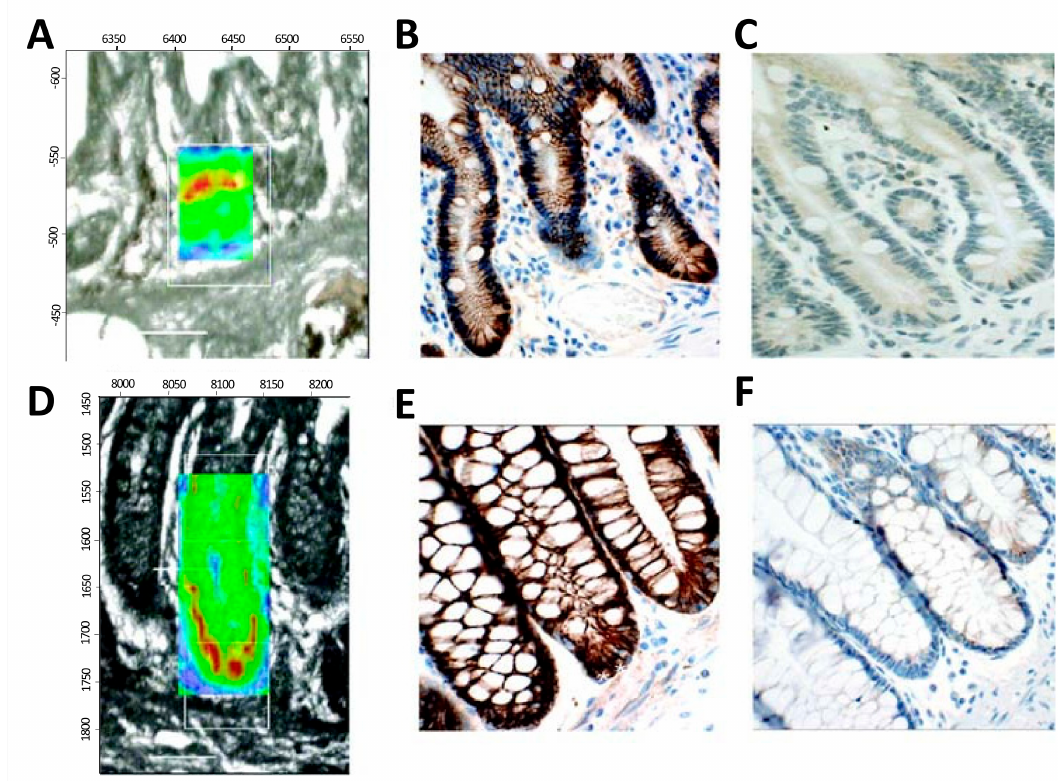
Figure 5. Localisation of the putative stem cell region in an IR spectral image (resolution of 8 µ m × 8 µ m) map of intestinal crypts obtained using synchrotron FTIR micro-spectroscopy; a comparison with proposed immunophenotypical markers. ( A ): Two-dimensional (2D) map of a small intestinal crypt, smoothed at the wavenumber 1080 cm − 1 and superimposed on the unstained region analysed. ( B ): A representative photomicrograph of a parallel section containing small intestinal crypts stained with mouse monoclonal anti- β -catenin antibody. Note nuclear immunoreactivity in Paneth cells, identified by their pyramidal shape and “foamy” cytoplasm. ( C ): A representative photomicrograph of a parallel section containing small intestinal crypts stained with rabbit polyclonal anti-CD133 antibody. Weak immunoreactivity varied little along the length of the crypt. ( D ): 2D map of a large intestinal crypt, smoothed at the wavenumber 1080 cm − 1 and superimposed on the unstained region analysed. ( E ): A representative photomicrograph of a parallel section containing large intestinal crypts stained with mouse monoclonal anti- β -catenin antibody. In a single crypt two nuclei (*) showed weak nuclear immunoreactivity. ( F ): A representative photomicrograph of a parallel section containing large intestinal crypts stained with rabbit polyclonal anti-CD133 antibody. Weak cytoplasmic immunoreactivity was observed throughout the length of the crypt. Spectral intensity is represented as thermal color changes (blue < green < yellow < red). The synchrotron FTIR micro-spectroscopy experiments were carried out at the European Synchrotron Radiation Facility. (Reproduced with permission